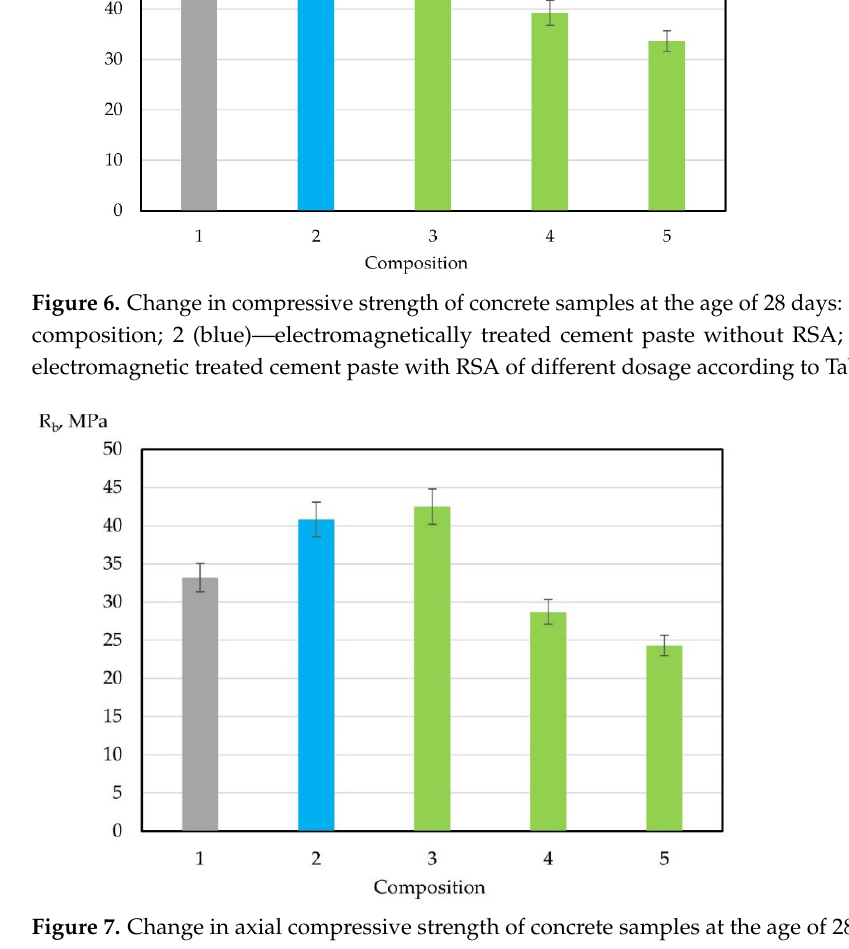
Figure 8. Change in axial tensile strength of concrete samples at the age of 28 days: 1 (grey)—con- trol composition; 2 (blue)—electromagnetically treated cement paste without RSA; 3, 4, 5 (green)— electromagnetic treated cement paste with RSA of different dosage according to Table 6.